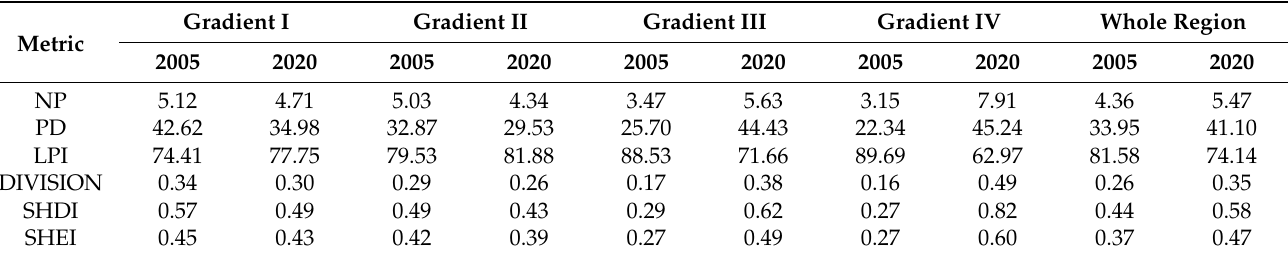
Table 6. Values of landscape metrics in 2005 and 2020.